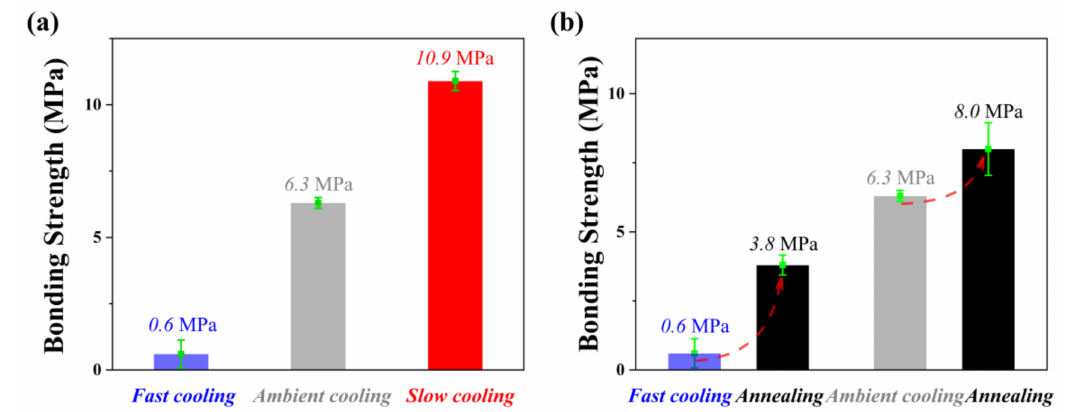
Figure 8. The thermal treatment influence on the bonding strength of PBMA/Al. ( a ) Different cooling rates; ( b ) annealing at 80 ◦ C for 2 h.